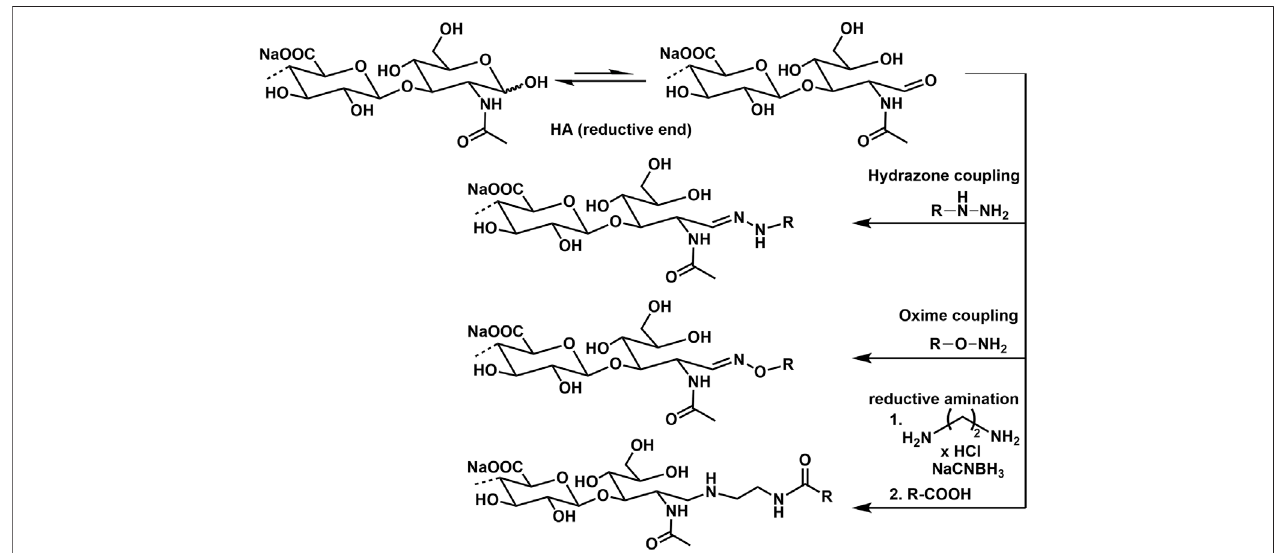
FIGURE 12 | Conjugation of amino group containing molecules at the reducing end of